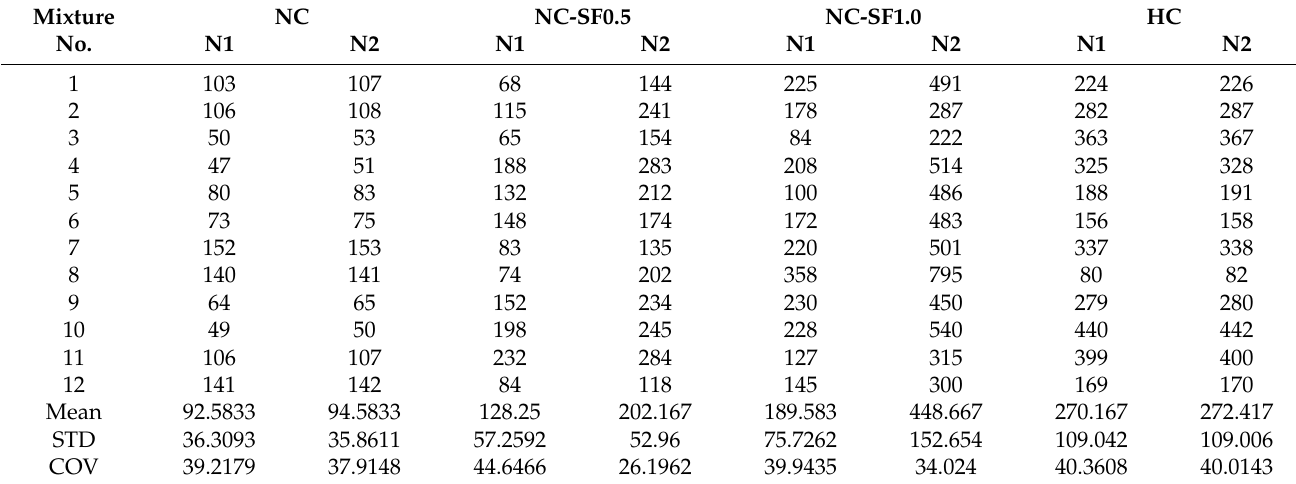
Table 4. Cracking and failure impact numbers of the two batches.